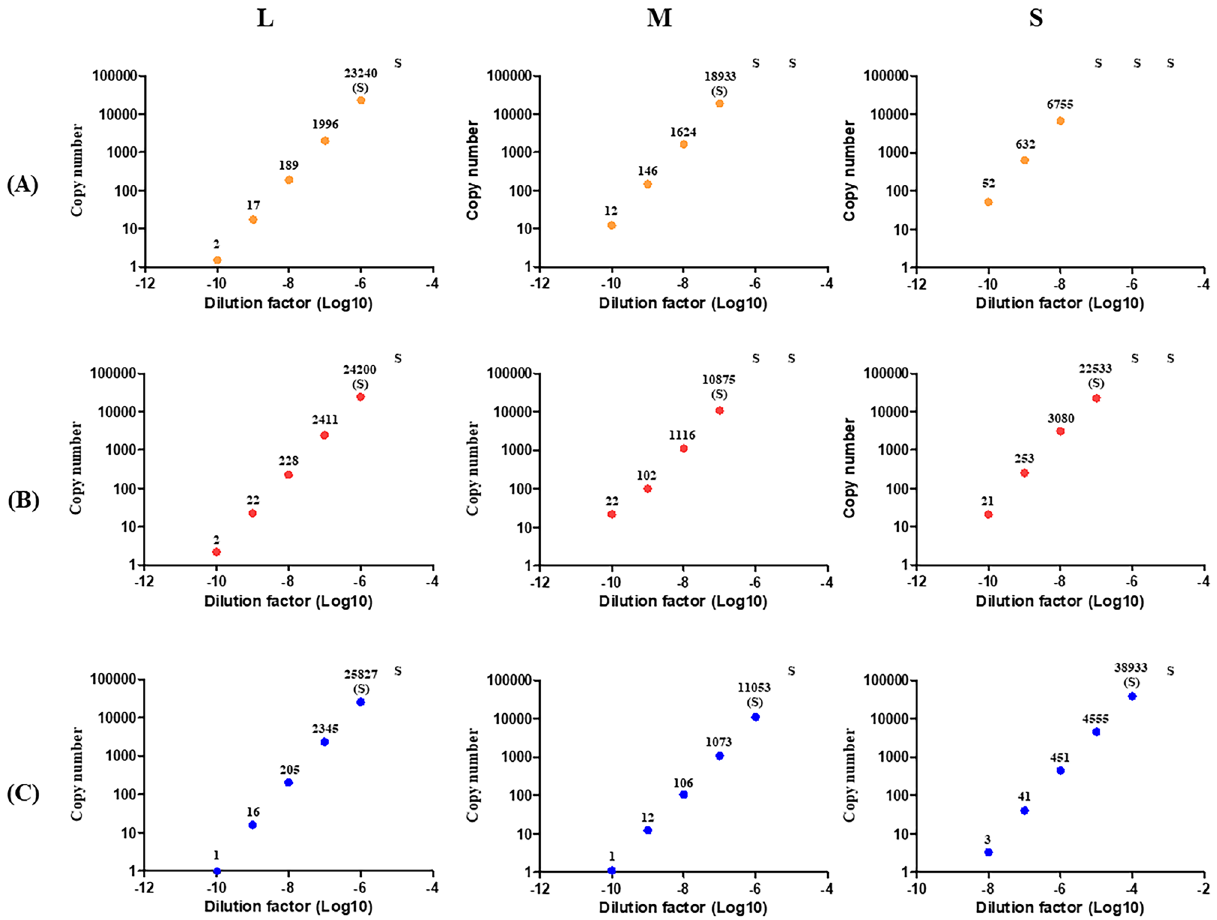
Figure 2. The copy number results of the RT-ddPCR. The ( A ), ( B ), and ( C ) indicate the BIME01, Kenya56, and ZH548 strains of the Rift valley fever virus, respectively. Each strain contains the L, M, and S segments. The number above the dot indicates average copy number and ‘S’ indicates